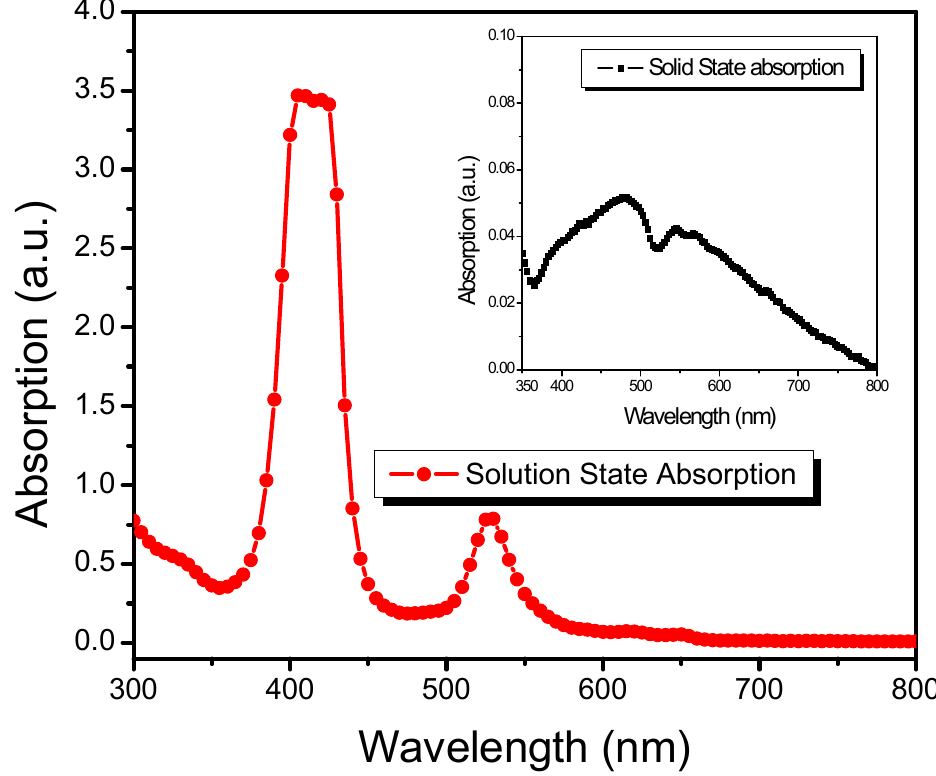
Figure 4. UV-vis absorption spectrum of TPPNi in solution state and (inset) solid-state (spin-coated thin film).